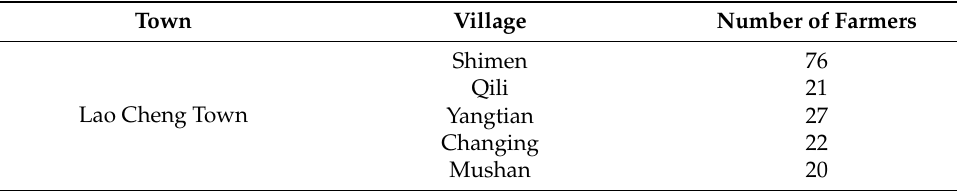
Table 1. Distribution of the survey